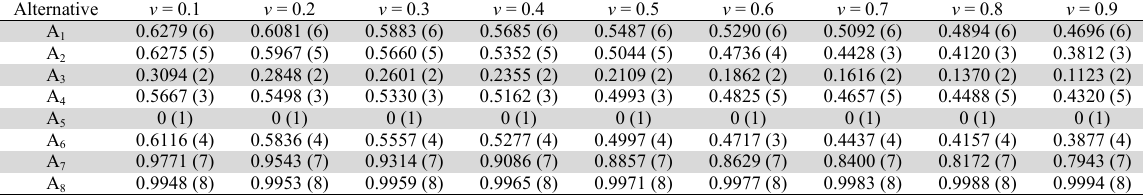
Change of ranking patterns with varying v values in regret theory-based VIKOR method Alternative